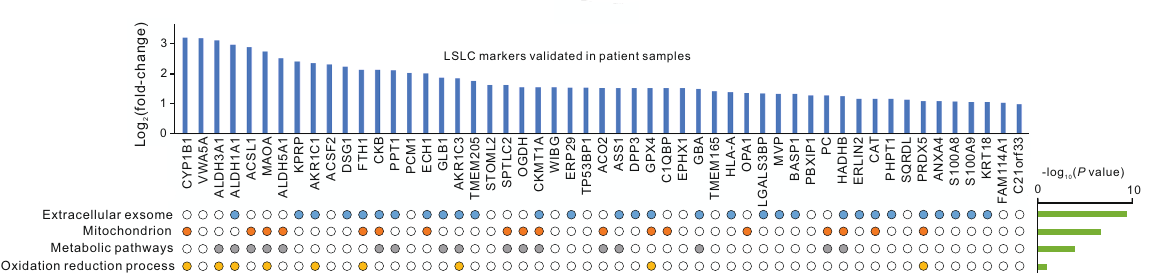
Fig. 8 The LSLC markers that are validated in patient samples. The gene annotations and their enrichment P values are shown at the